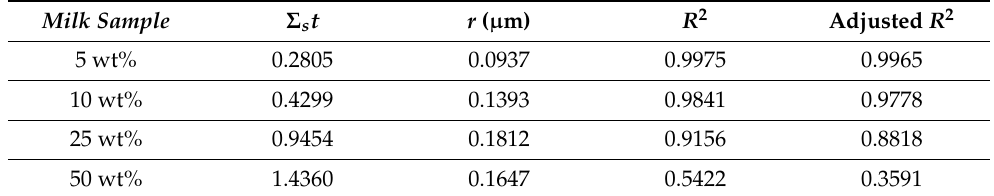
Table 3. Structural parameters and goodness of fits for fat globules (FG) in the deuterated milk samples with different fat contents derived using a model for polydisperse interacting spheres (Equations (7)–(13)).